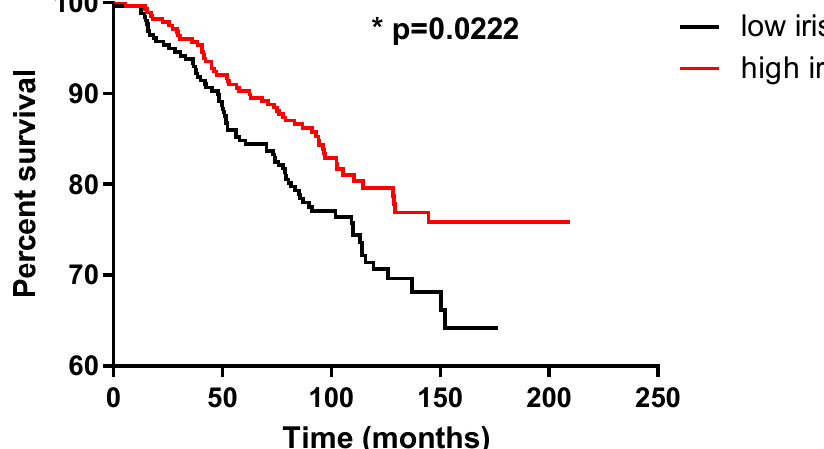
Figure 4. Kaplan–Meier survival curve presenting the prognostic impact of irisin expression levels using immunohistochemistry (IHC) on the overall survival (OS) of patients with breast cancer (BC). Patients were grouped according to the median value of irisin expression (5.3).